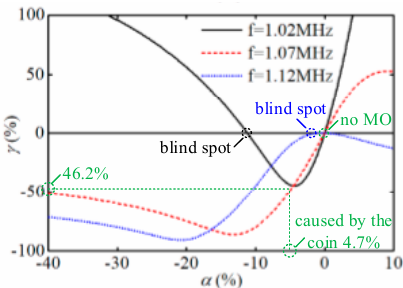
Figure 12. γ versus α at three different operating frequencies of the PS mixed resonant circuit.